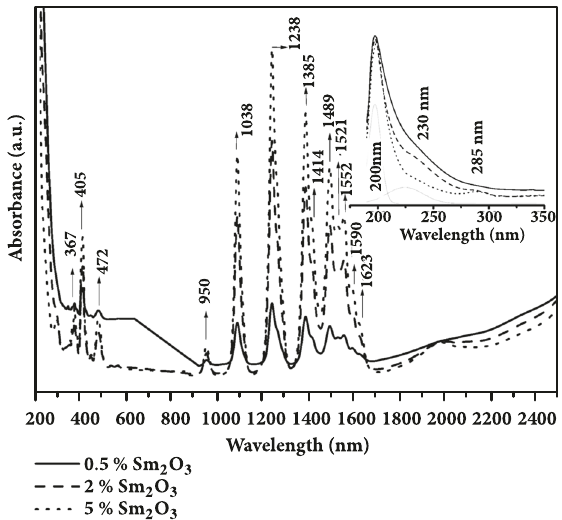
Figure 3: Optical absorption spectra of Sm 2 O 3 -doped glasses with attached deconvoluted spectrum (UV 200–350nm).